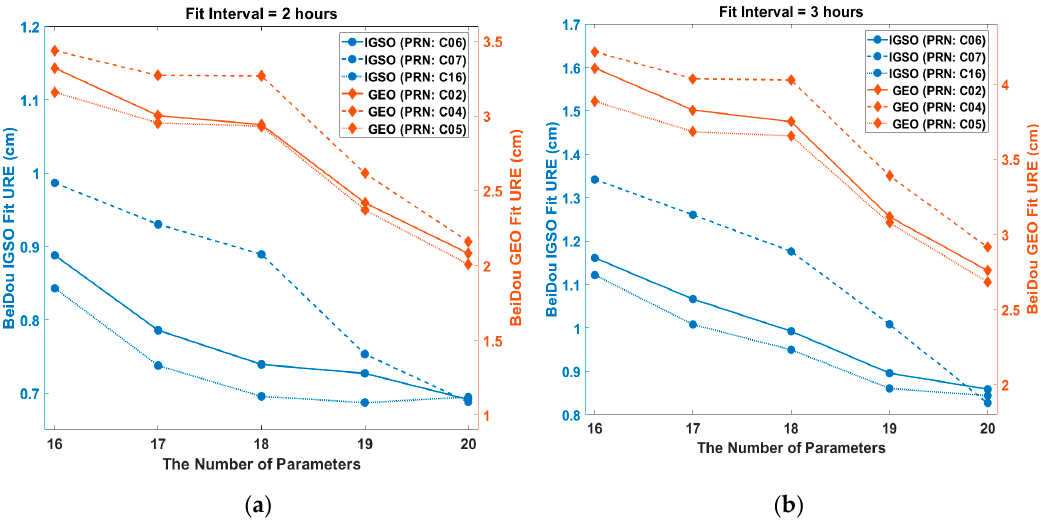
Figure 2. Fit URE for BeiDou IGSOs (PRN: C06, C07, and C16) and GEOs (PRN: C02, C04, and C05) vs. the number of parameters: ( a ) 2 h fit interval; ( b ) 3 h fit interval.